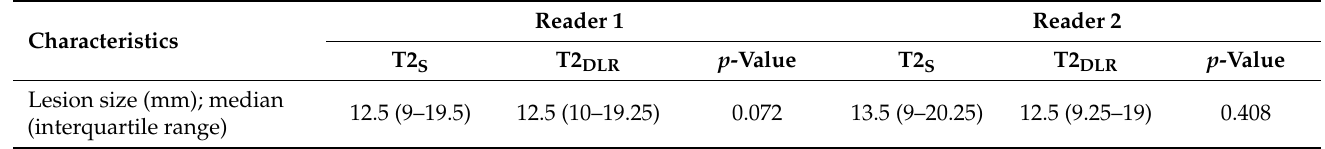
Table 5. Lesion size measurement in PI-RADS ≥ 3 (20